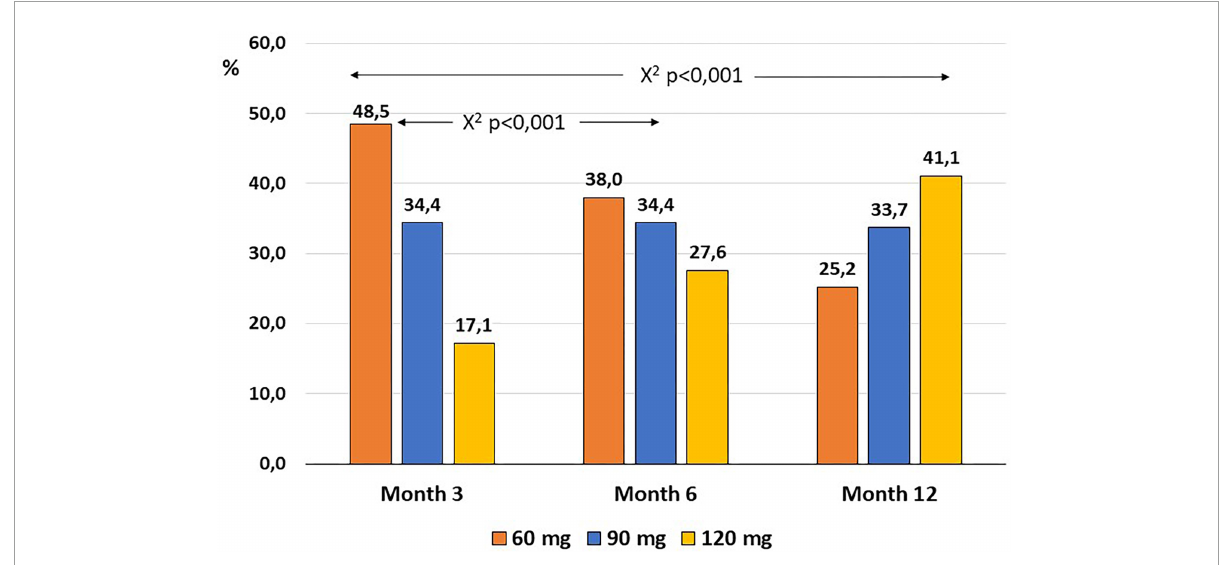
FIGURE2 Evolution of the proportion of patients taking each dose of tolvaptan in the first year of